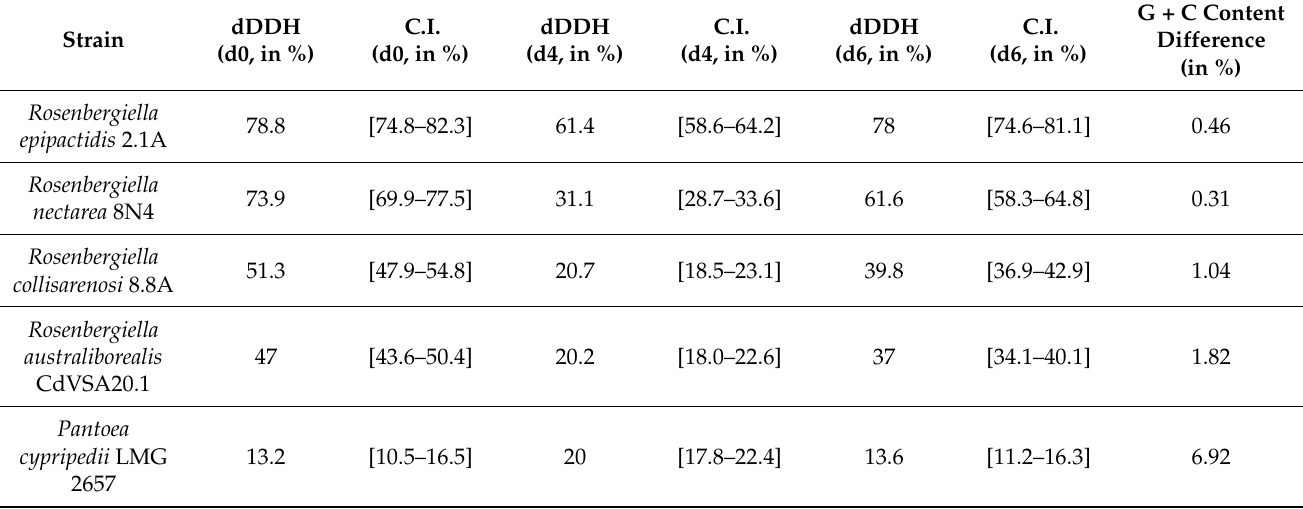
Table 2. Digital DNA-DNA hybridization (dDDH) values of R. meliponini D21B against sequenced Rosenbergiella strains calculated by TYGS (https://tygs.dsmz.de/) [40] . Legend: C. I.: confidence in- tervals, formula d0 (also known as Genome-to-Genome Distance Calculator (GGDC) formula 1): length of all high-scoring segment pairs (HSPs) divided by total genome length. Formula d4 (GGDC formula 2): sum of all identities found in HSPs divided by overall HSP length. Formula d6 (GGDC formula 3): sum of all identities found in HSPs divided by total genome length.